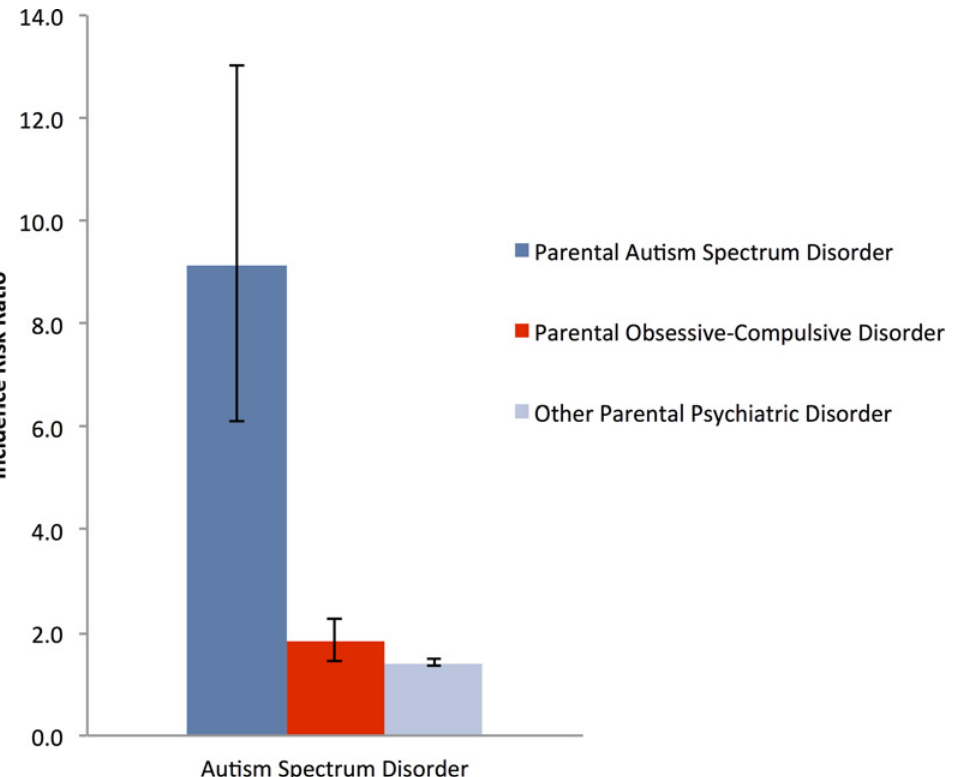
Fig 1. Incidence rate ratios, with 95% CIs (error bars), of Autism Spectrum Disorders in Offspring of Parents with an Obsessive Compulsive Disorder, 1995 – 2012.